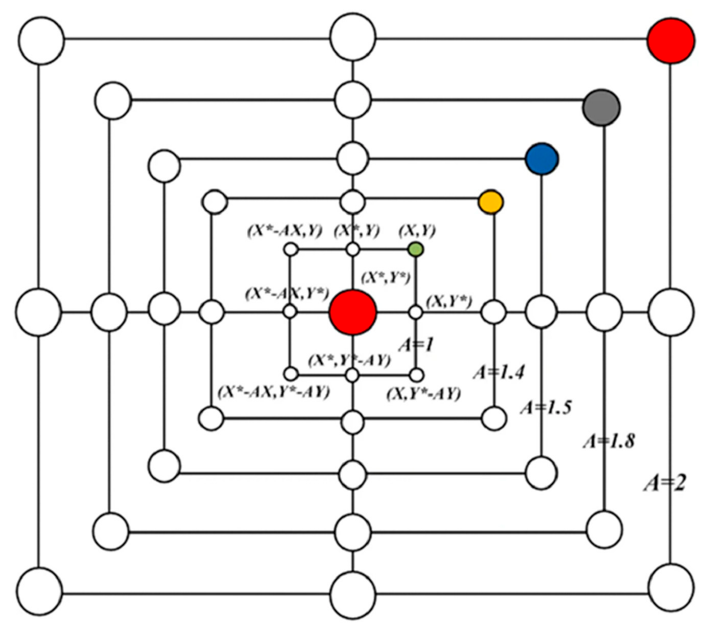
Figure 2. Exploration mechanism in WOA.